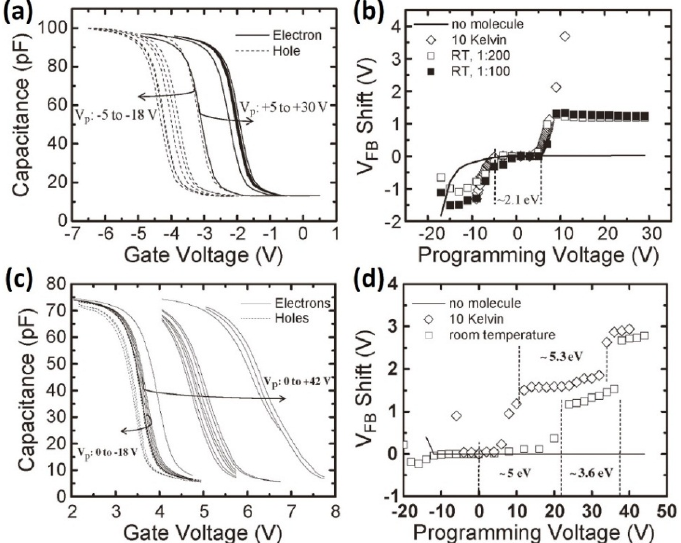
Figure 7. High-frequency C-V and ∆ V FB as a function of programming voltage at 10 K and room temperature for the device with ( a , b ) FcCOOH and ( c , d ) CoP molecules. Reproduced with permission from [42], © IEEE, 2011.